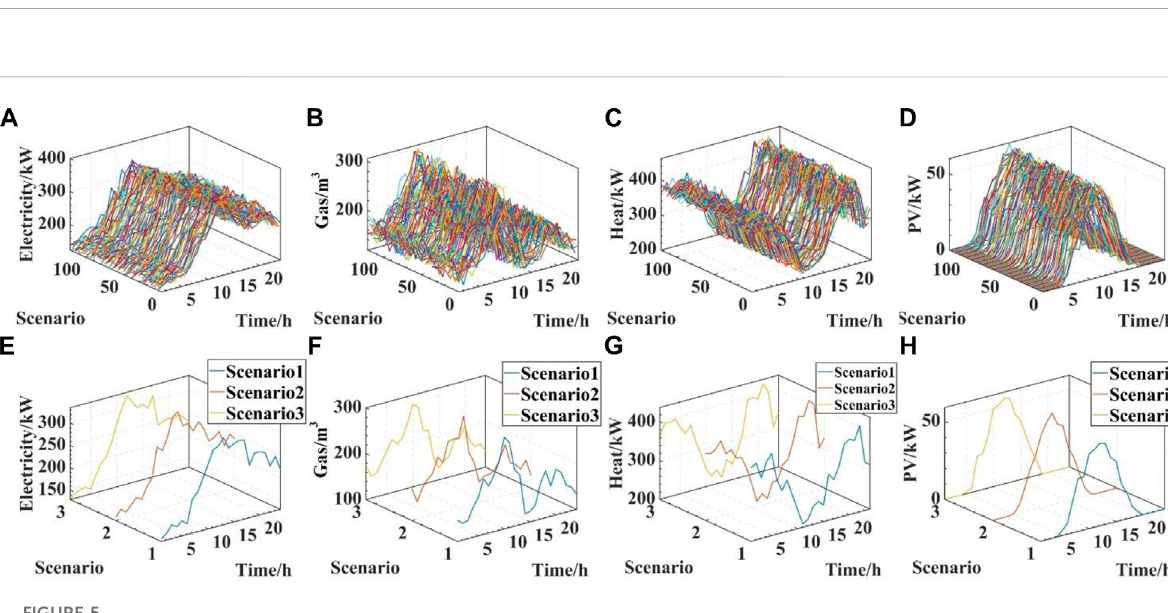
FIGURE 5 DCGAN-generated scenarios for: (A) electricity loads; (B) gas loads; (C) heat loads; (D) PV outputs; reduced scenarios by K-means clustering in the corresponding DCGAN-generated scenarios for: (E) electricity loads; (F) gas loads; (G) heat loads; (H) PV outputs.